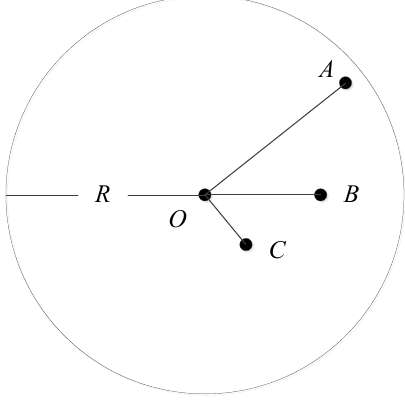
Figure 2. Schematic diagram of hop error.